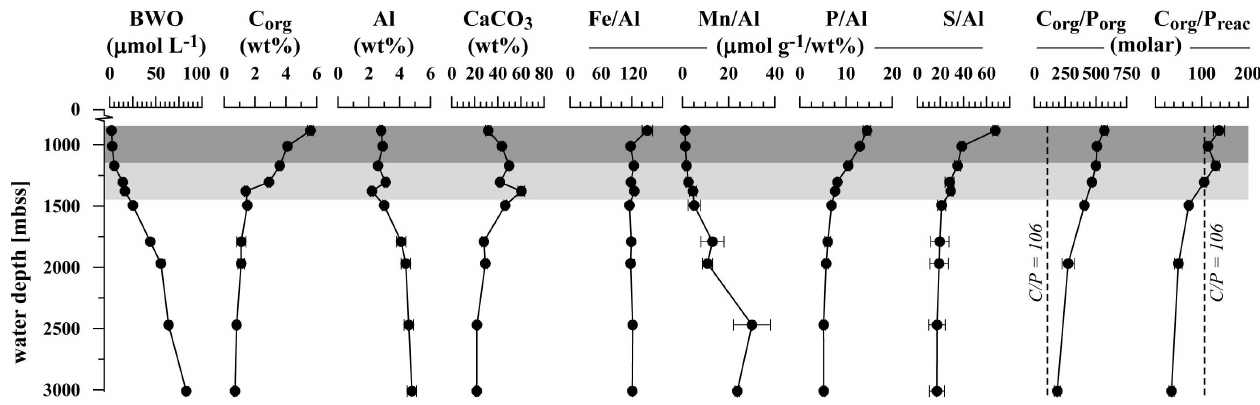
Fig. 3. Trends with water depth for bottom water oxygen (BWO) concentration and average total solid-phase C org content and Al, Fe, Mn, P, S concentrations (normalized to Al) in the top 2cm of the sediment. Also included are the average molar organic C/organic P (C org /P org ) and organic C/reactive P (C org /P reac ) ratios in the top 2cm for the selected stations for which sequential P extractions were performed. Dashed vertical lines indicate the C/P ratio of marine organic matter of 106 (Redfield, 1958). The dark grey area indicates the centre of the OMZ defined by O 2 < ∼ 4.5µM; the light grey area indicates the extent of oxygen-depleted water up to the lower boundary of the OMZ defined by O 2 ∼ 22µM after Cowie and Levin (2009). Error bars indicate 1 standard